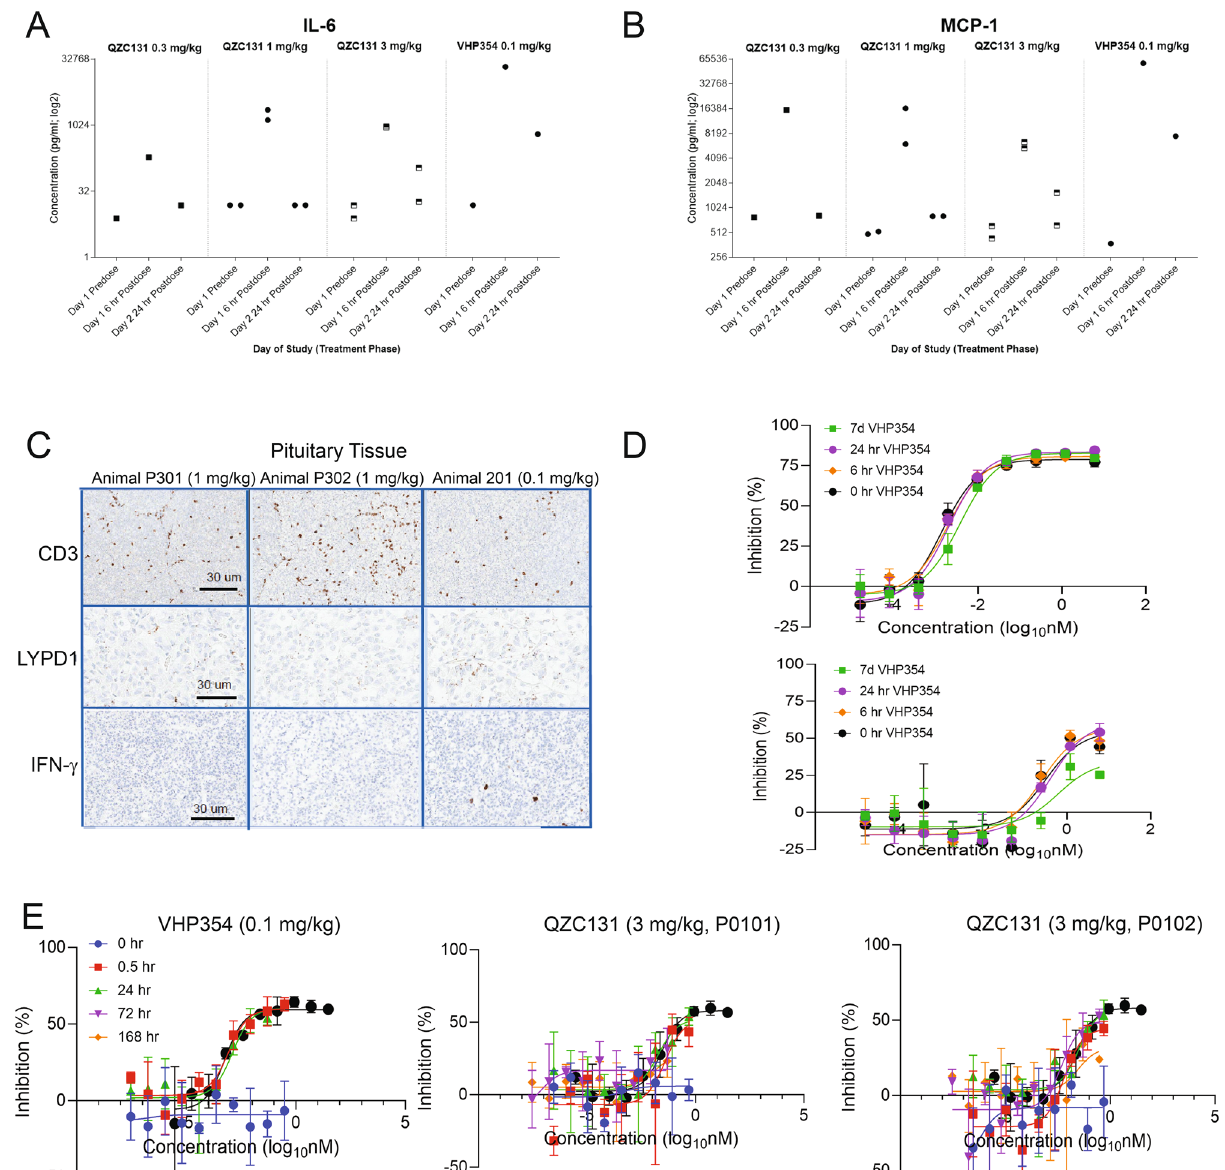
Figure 4. Toxicology study of VHP354 and QZC131 in cynomolgus monkeys demonstrates systemic cytokine release syndrome to be affinity-driven. ( A , B ) Treatment of cynomolgus monkeys with LYPD1-directed TCBs VHP354 and QZC131 showed increased serum IL-6 and MCP-1 at 6 h post-dose with partial to complete resolution by 24 h post-dose. Cytokine changes by greater than 2-fold were considered meaningful. ( C ) IHC of CD3 + infiltrates showed increased CD3 + cells in the pituitary tissue across all dose groups with a correlative increase in IFN-γ levels in the pituitary of all dosed animals. Scale bar represents 30 µm. ( D ) RTCC assays with LYPD1-high expressing cells U251 demonstrate selective and dose-dependent induction of T cell-mediated cytotoxicity for VHP354 and QZC131 following 0, 6, 24, and 168 h incubation in cynomolgus serum at 37 °C. 10-point dose response curves from a starting concentration of 30 nM of VHP354 or QZC131 at 0 h (black), 6 h (orange), 24 h (purple), and 168 h (green) demonstrate comparable activity across time-points. ( E ) RTCC assays with DMS273-LYPD1 expressing cells demonstrate selective and dose-dependent induction of T cell-mediated cytotoxicity from animal P0201 serum for VHP354 (0.1 mg/kg) at 0.5 and 24 h post-dose and from animals P0101 and P0102 (3 mg/kg) for QZC131 (3 mg/kg) at 0.5, 24, 72 and 168 h post-dose. 10-point dose response curves from a starting concentration of 30 nM of VHP354 or QZC131 serum spike-in control (black), 0.5 h (red), 24 h (green), 72 h (purple) and 168 h (orange) demonstrate comparable activity across